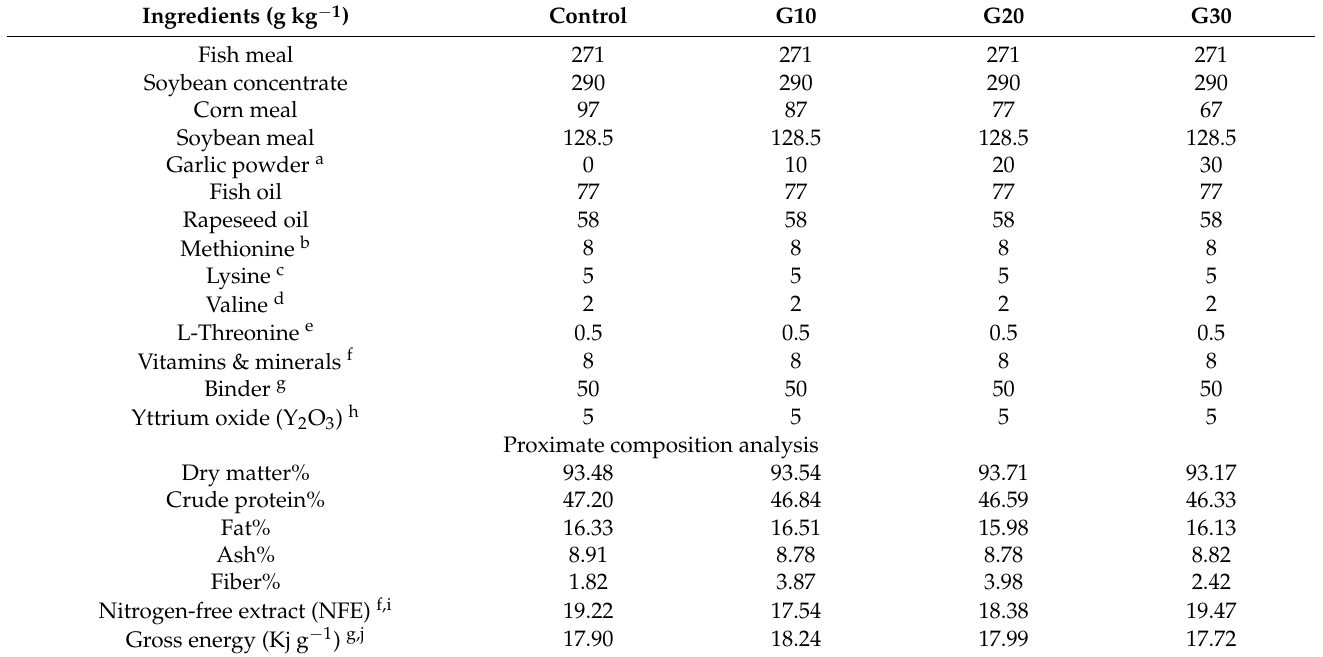
Table 1. Proximate composition of experimental diets with and without garlic